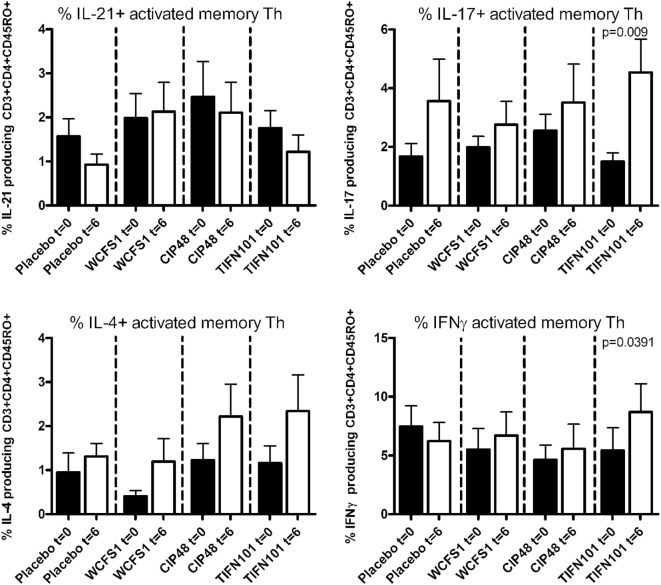
Effects of three Lactobacillus plantarum strains on the frequency of IL-21, IL-17, IL-4, and IFN-γ-producing tetanus toxoid-stimulated memory-CD45RO+ Th cells. Data are expressed as mean ± SEM. Statistical significant differences were determined by using two-sided Student’s t-tests. A p-value <0.05 was considered statistically significant. A p-value <0.1 was considered a statistical trend.